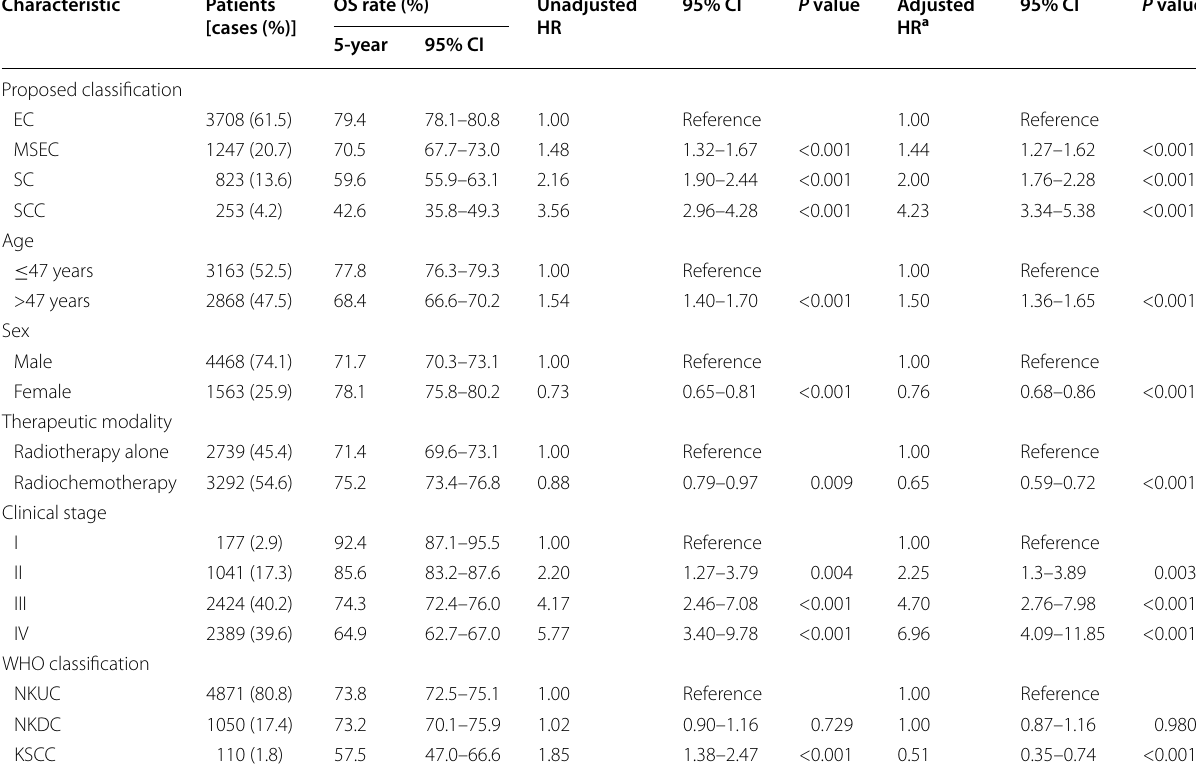
Table 4 Cox proportional regression analysis of the associations between patient characteristics and OS in all 6031 NPC